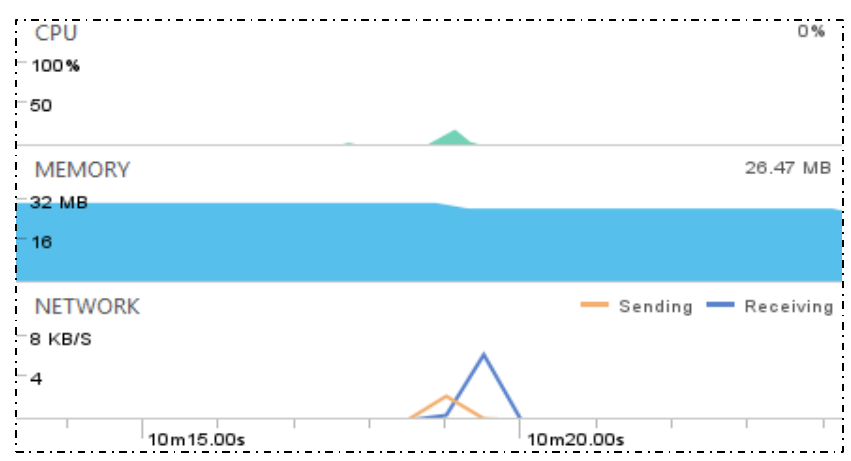
Figure 18. Status of IoT proxy for accessing a WSP service through IoT proxy.